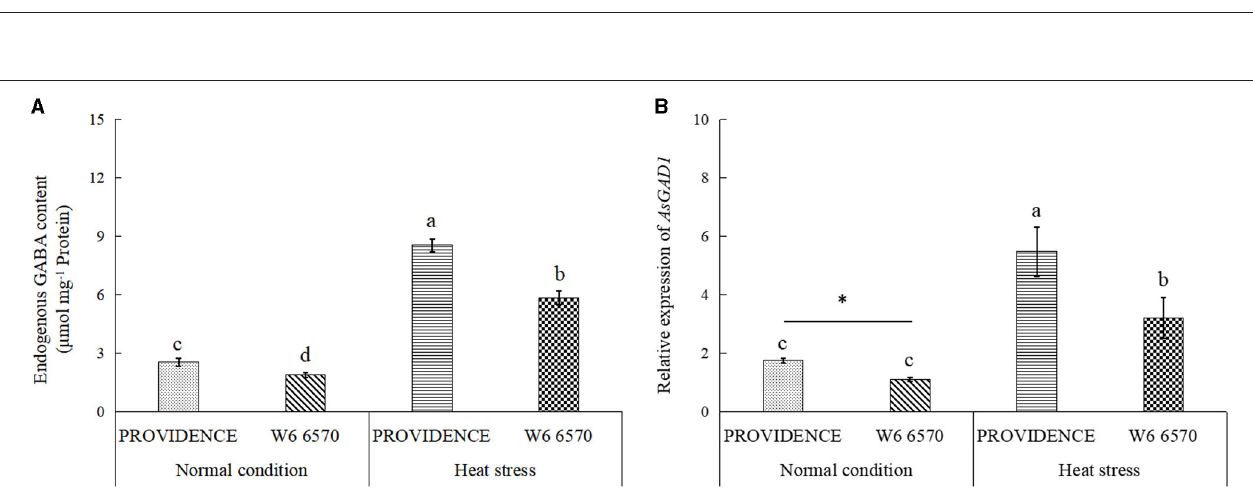
FIGURE 5 | Changes in transcript levels of (A) superoxide anion content, (B) hydrogen peroxide content, (C) malondialdehyde content, and (D) total antioxidant capacity in the leaves of two creeping bentgrass materials (PROVIDENCE and W6 6570) under normal conditions or heat stress (38/33 ◦ C, day/night) in controlled growth chambers. Vertical bars indicate ± SE of mean ( n = 4). Different letters above column indicate significant differences ( P ≤ 0.05) in a particular material (PROVIDENCE or W6 6570) under normal conditions and heat stress. The asterisk “*” indicates significant differences ( P ≤ 0.05) between PROVIDENCE and W6 6570 at one specific time point (3h, 3 day, or 10 day).